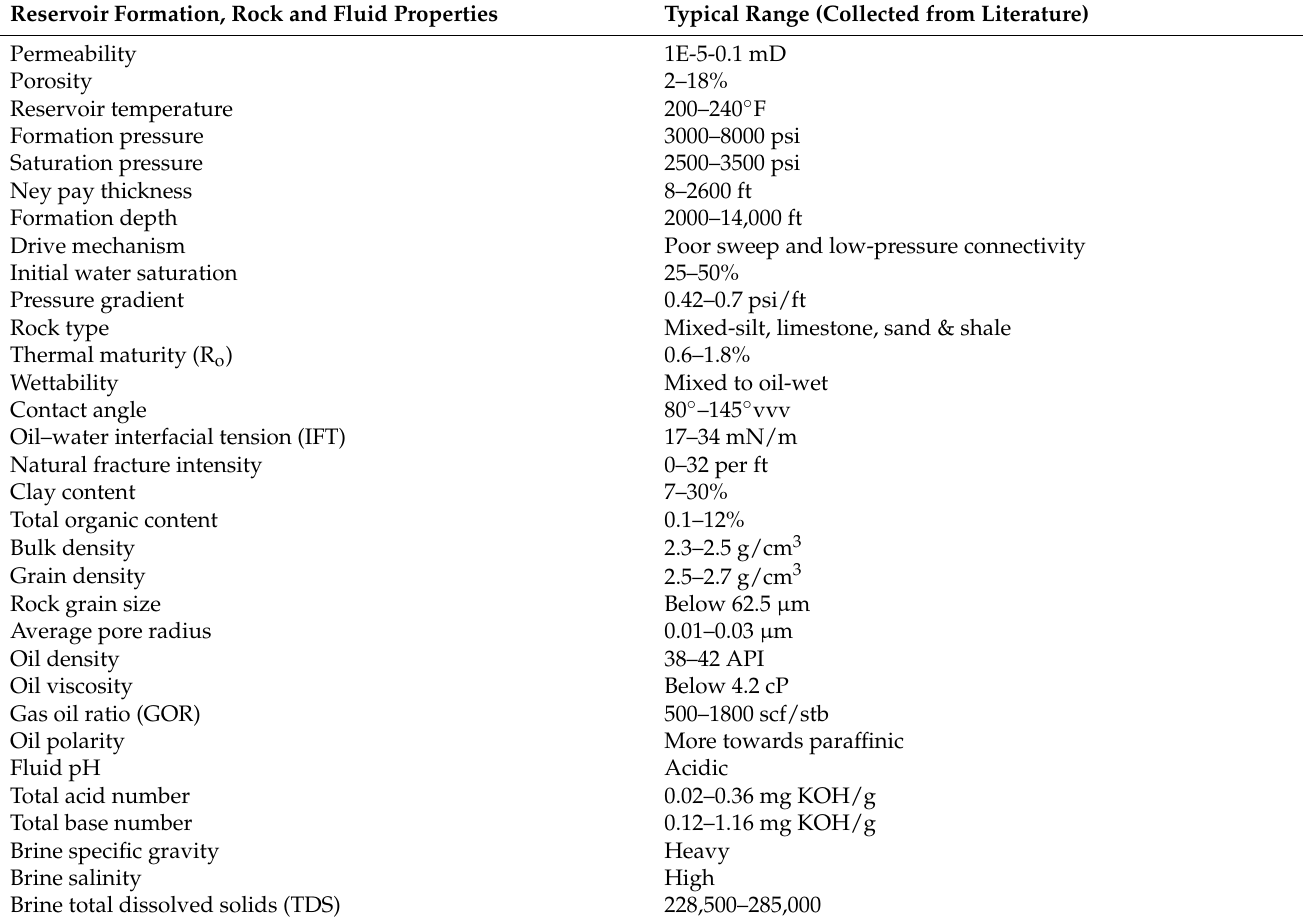
Table A1. Typical rock/formation and fluid properties of shale oil reservoirs.